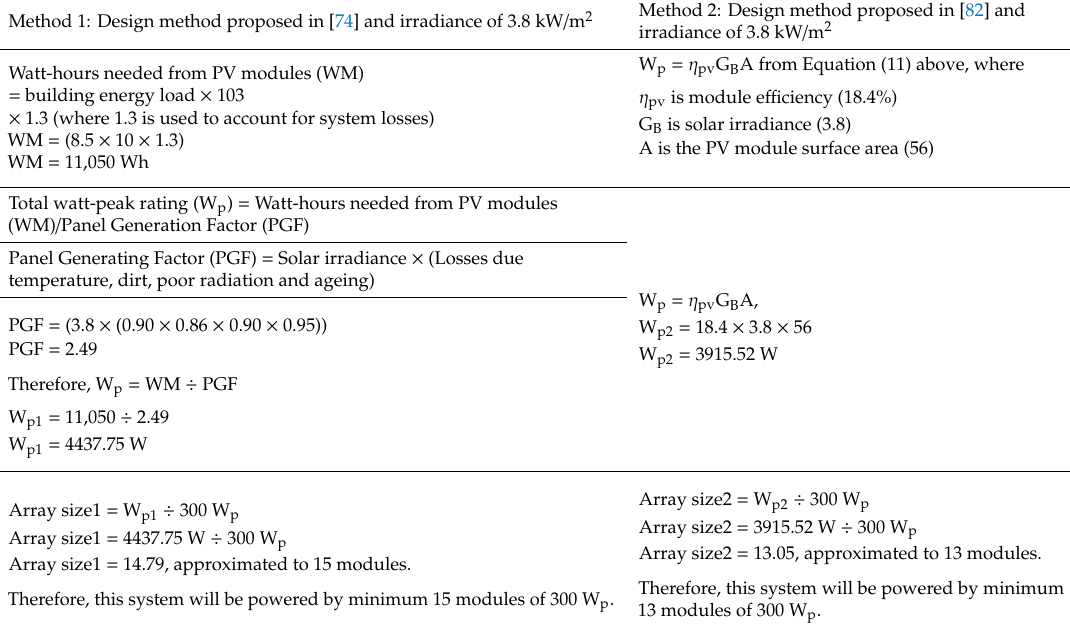
Table 4. Calculations for Energy